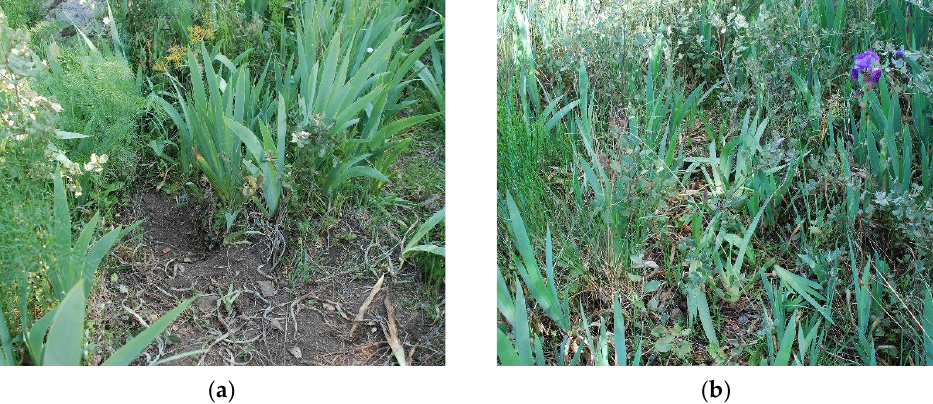
Figure 6. Examples of human impact in the environment of the Teso de San Cristóbal in the active search for specimens of Ophrys scolopax : ( a ) excavated and cleared soil by people looking for the tubers, and ( b ) trampling of basal leaves of different plants. Images taken in 2011, in the initial stage of the study (photos by J.A. González).